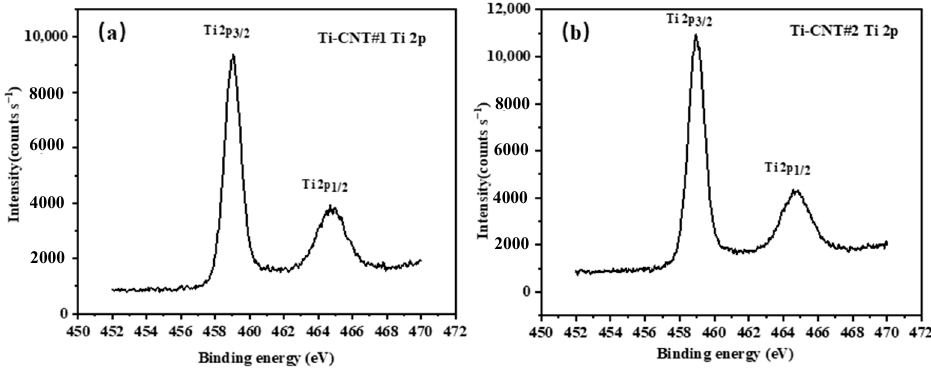
Figure 5. The XPS spectrum of Ti 1 p states of ( a ) Ti-CNT #1 and ( b ) Ti-CNT #2.